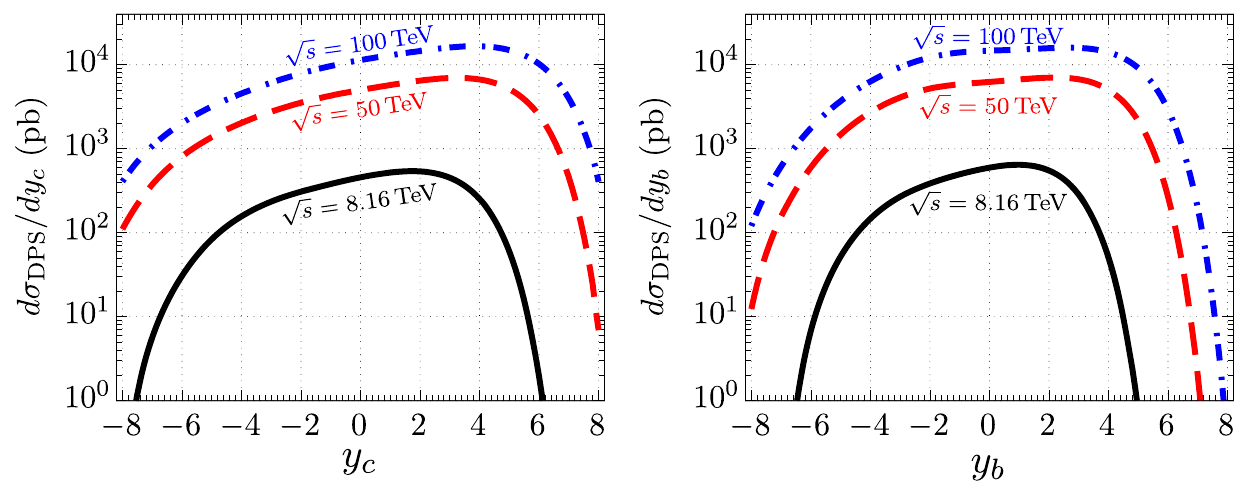
Fig. 7 DPS c ¯ cb ¯ b production cross section in pA UPCs as a function of c rapidity with y b integrated (left panel) and as a function of b -quark rapidity with y c integrated (right